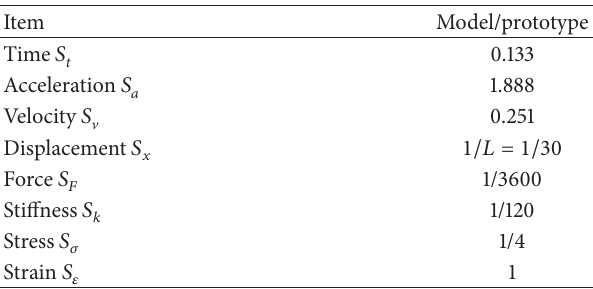
Table 5: Main similitude